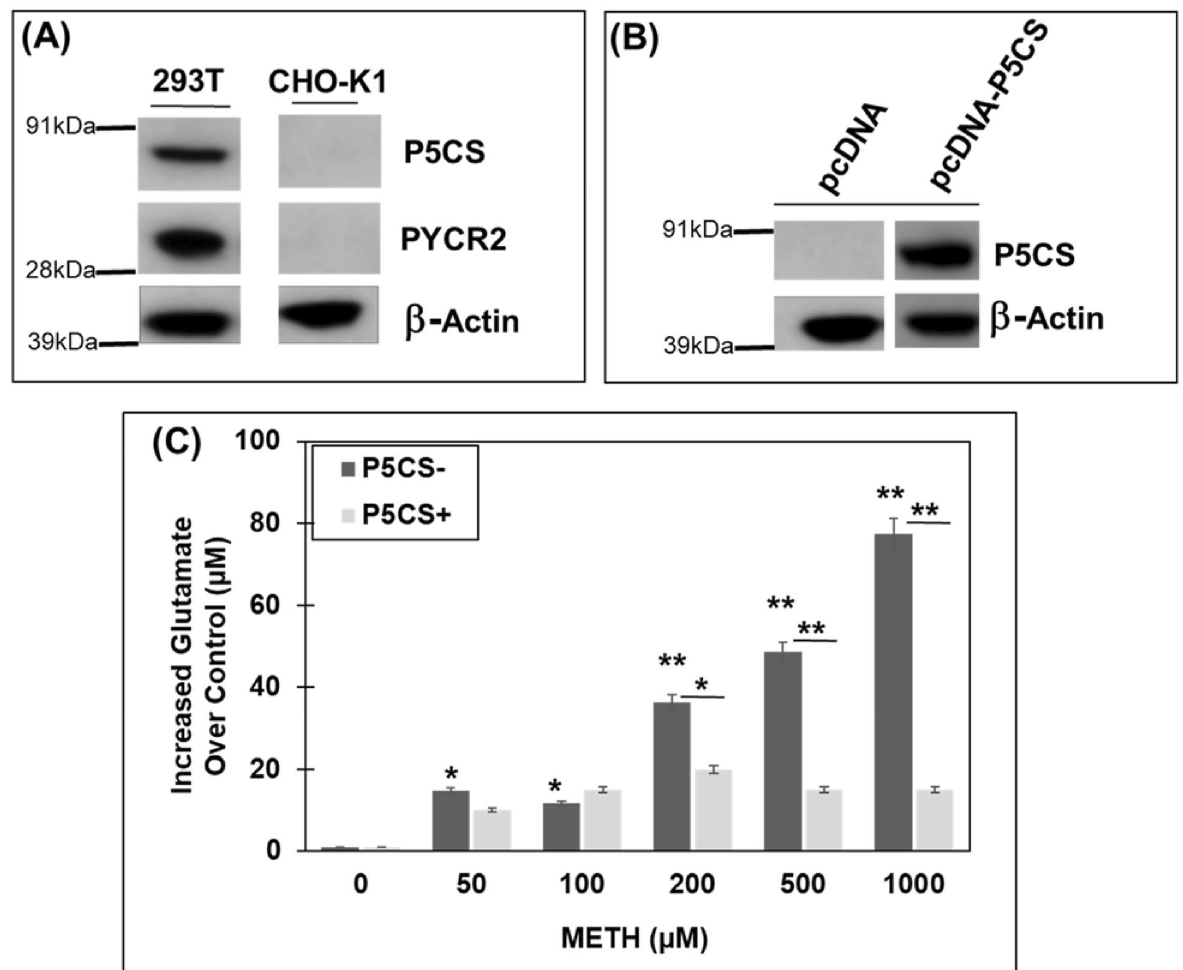
Figure 5. METH treatment increases glutamate levels in proline-auxotrophic (CHO-K1) cells. CHO-K1 cells are proline auxotrophs that lack P5CS and PYCR2. ( A ) Western blot showing the absence of P5CS and PYCR2 in CHO-K1 cells (n = 3). β-actin was used as loading control. HEK293T cells that express both P5CS and PYCR2 was used as positive control. ( B ) Overexpression of P5CS in CHO-K1 cells. An expression construct of P5CS was generated using pcDNA 3.1. CHO-K1 cells were transfected with either pcDNA-empty vector or pcDNA- P5CS and post-transfection western blot was performed to confirm the expression of P5CS (n = 3). β-actin was used as a loading control. ( C ) Effect of METH treatment on glutamate levels in CHO-K1 in the presence and absence of P5CS expression. CHO-K1 cells were transfected with either pcDNA-empty vector or pcDNA- P5CS . Post-transfection the cells were treated with varying concentrations of METH under acute conditions. Glutamate levels were measured in the cell-free supernatants after 24 h (n = 3). Data represent the increase in glutamate levels over control untreated cells and are the mean ± SEM of at least three independent experiments. In ( C ), *p < 0.05, **p < 0.005 represents statistical comparison of untreated vs METH-treated cells shown in black bars, whereas *p < 0.05, **p < 0.005 represents comparison of METH-treated cells in the absence and presence of P5CS shown in gray